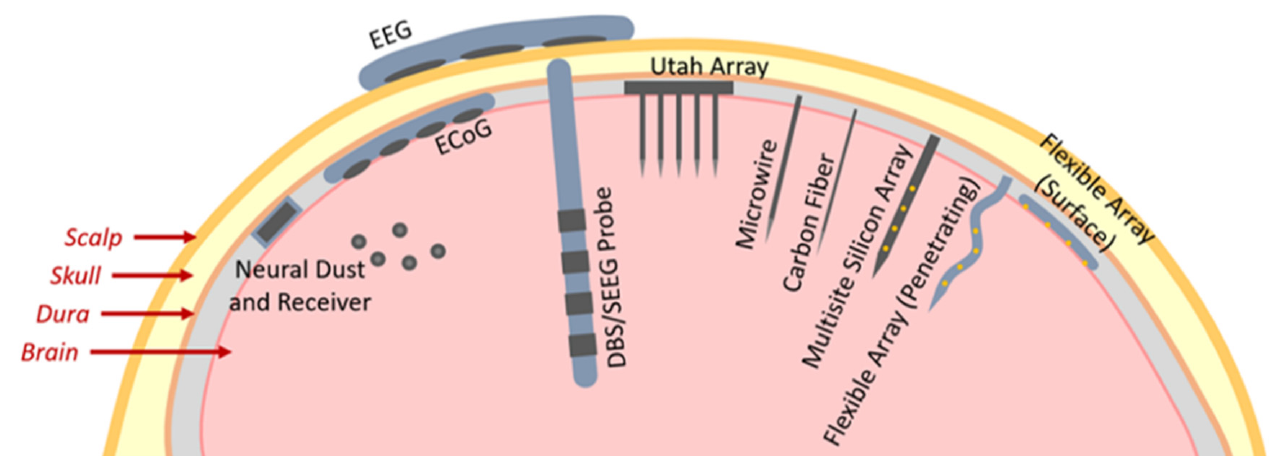
Figure 1. The major types of neural electrode interfaces in brain [33].